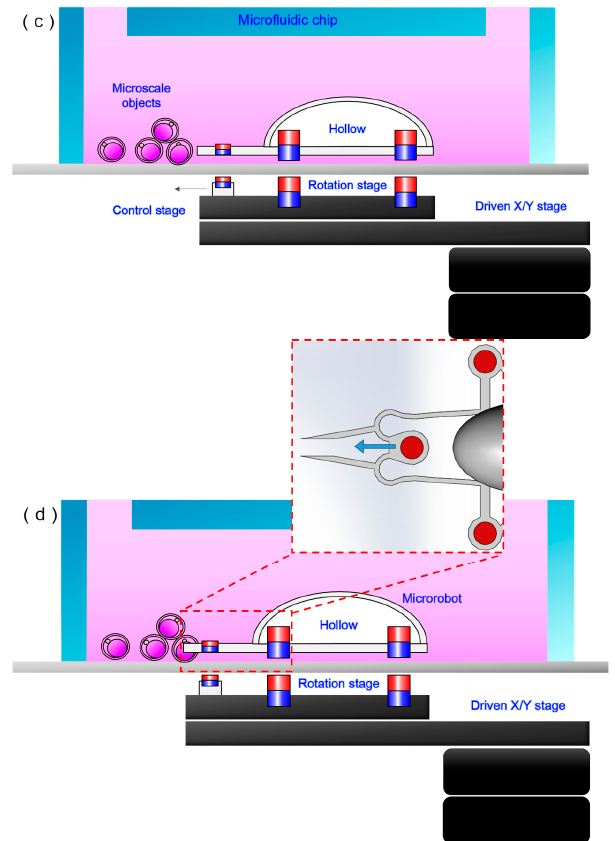
Figure 3. Schematic of the 3D microrobot control. The robot moves towards the stage when the stage moves towards the microfluidic chip, and when the stage moves away from the microfluidic chip, the robot moves away from the stage. ( a , b ) Control the robot to the intended position using the driven stage. ( c , d ) Move the control stage to adjust the state of gripper, to grip the microscale